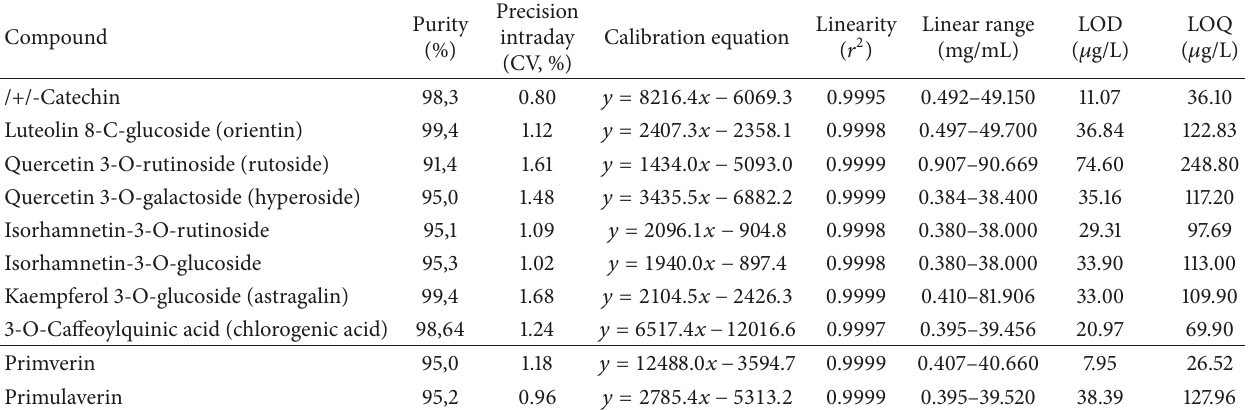
Table 1: Validation parameters of the HPLC-DAD analysis ( 𝑛 = 6